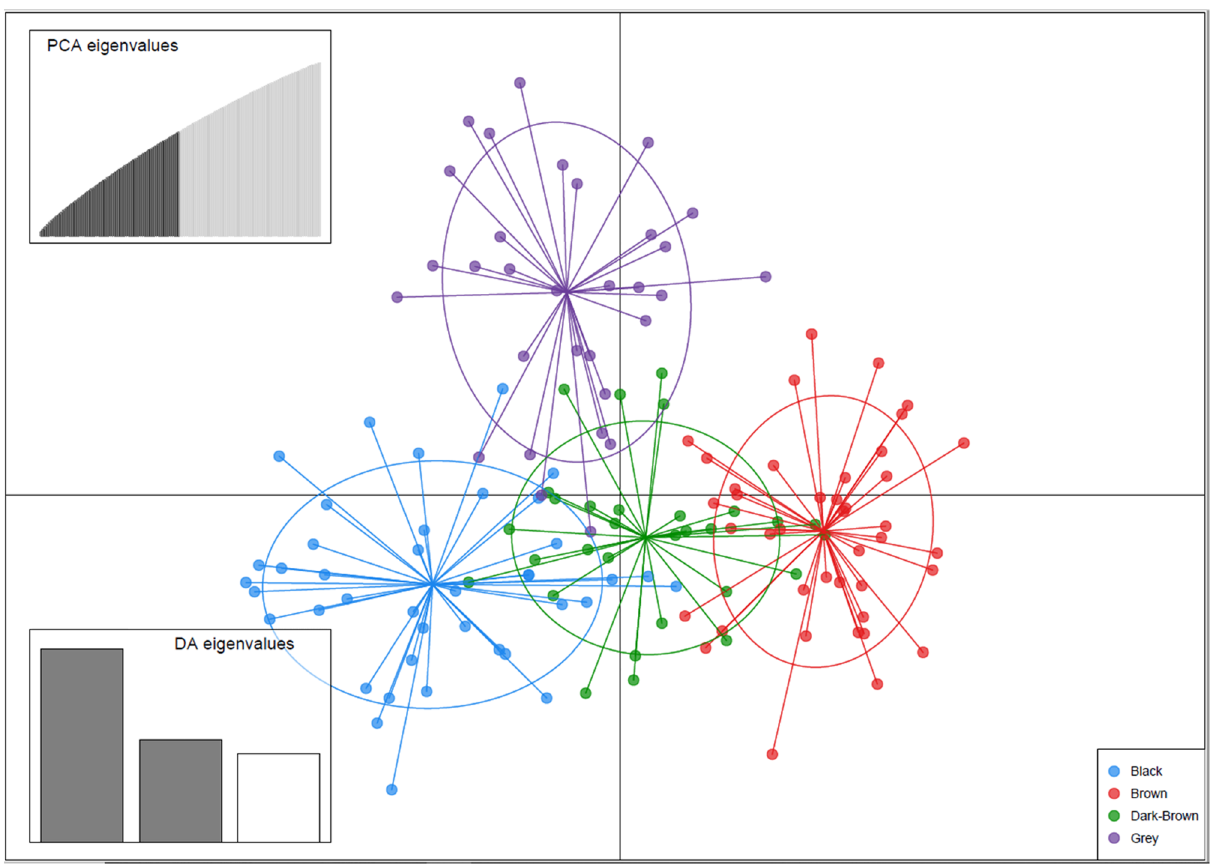
Figure 4. Discriminant analysis of principal component (DAPC) using the 19,853 SNPs of 141 alfalfa genotypes representing 14 alfalfa populations with long-term grazing history sampled across four soil zones of Saskatchewan, Canada. Each dot represents individual alfalfa genotype and the bottom right inset illustrates the legend for four soil zones.